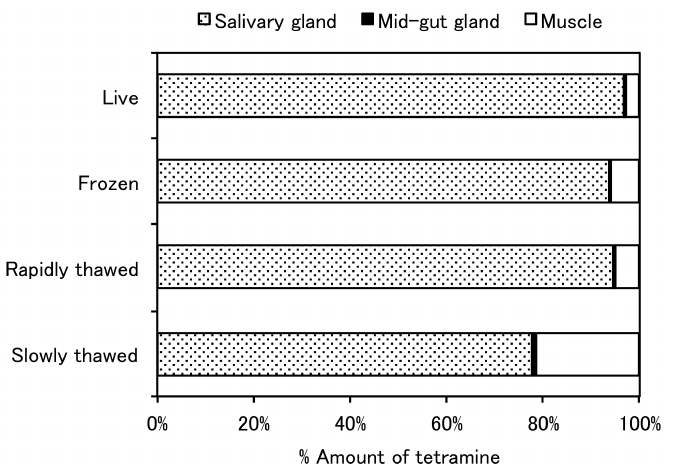
Figure 4. Tetramine contents in tissues (salivary gland, mid-gut gland, and muscle) of live, frozen, rapidly thawed, and slowly thawed specimens of Neptunea polycostata . Drawn from the data in Tables 1 and 3 in the paper of Kawashima et al. [46]. Three live specimens were analyzed for tetramine in the salivary gland, mid-gut gland, and muscle. Nine live specimens were frozen at − 20 ◦ C for 2 weeks and each group of three specimens was analyzed for tetramine in the salivary gland, mid-gut gland, and muscle without thawing, after rapid thawing with running water for 1 h, and after slow thawing at 4 ◦ C for 24 h, respectively. Data are expressed as the mean of three specimens.